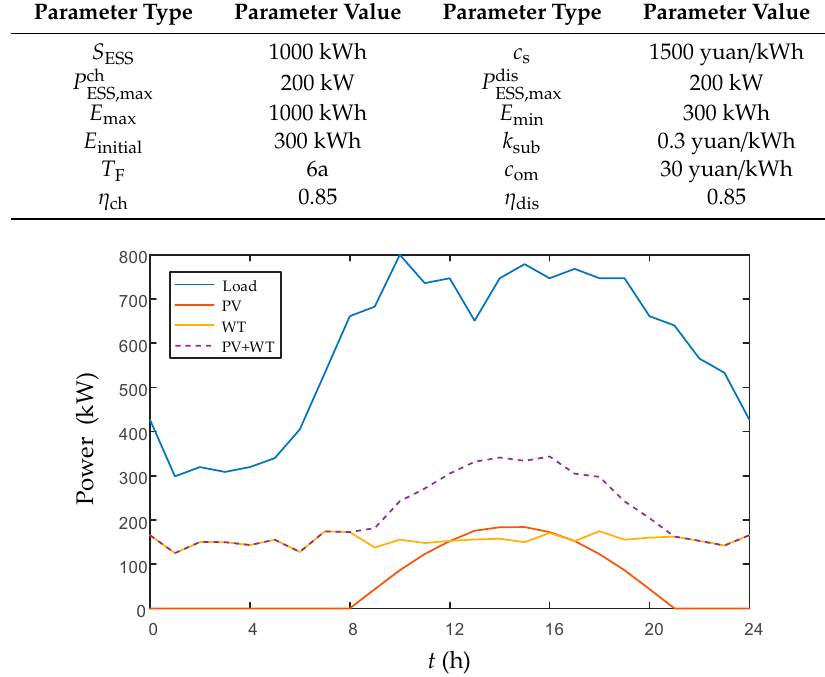
Figure 2. Typical load, PV, and WT profiles.